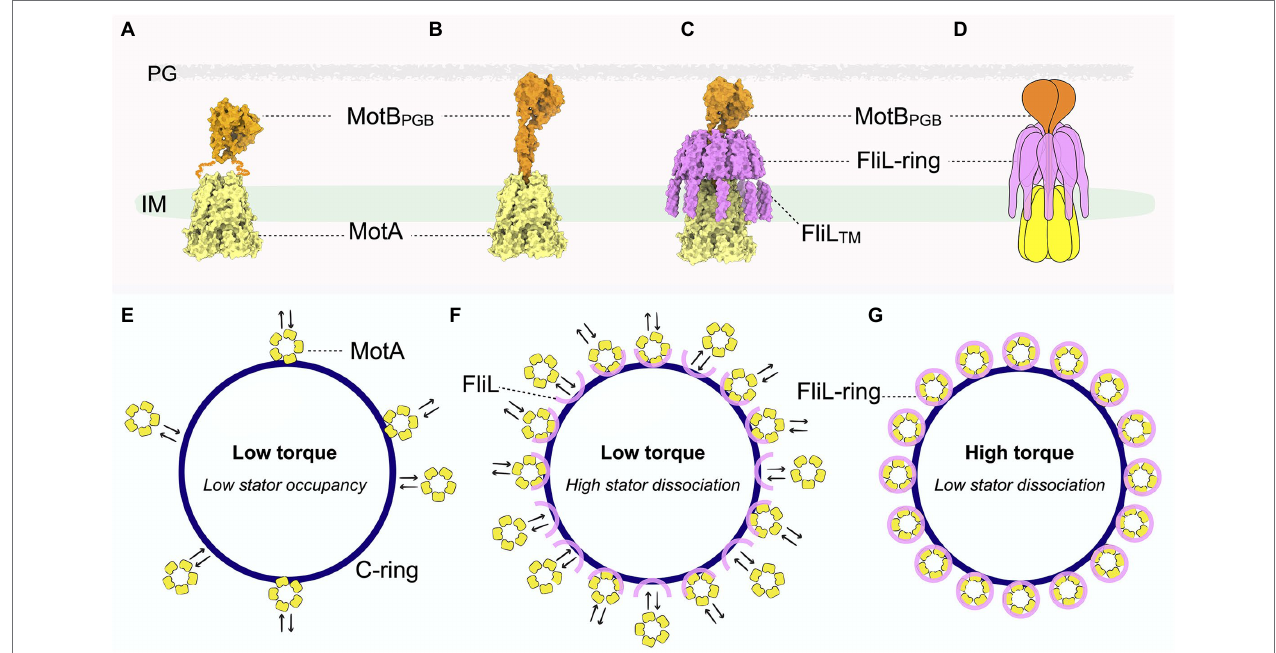
FIGURE 2 | Pseudoatomic structure of the stator-FliL-supramolecular complex and proposed model for modulating torque generation. (A) Side view of the stator structure in its compact, inactive conformation. MotA is colored yellow and MotB orange. The squiggly orange lines indicate the flexible MotB linkers with unknown structure. The cryo-ET map for the inner membrane is colored green. (B) Side view of the pseudoatomic model of the stator complex in its extended, active conformation. (C) Side view of the pseudoatomic model of the stator-FliL supramolecular complex. The FliL-ring is colored magenta. (D) Cartoon representation of the stator-FliL supramolecular complex. (E) In the absence of FliL, the stator units rapidly bind and unbind the rotor. Low stator occupancy results in low torque production by the motor. (F) Under low-load conditions, stator units bind and unbind the rotor rapidly before FliL can properly assemble into full rings to enclose the stator. (G) Under high-load conditions, FliL forms a full ring to surround and stabilize the stator complex in its active, extended conformation to maximize PMF to generate high